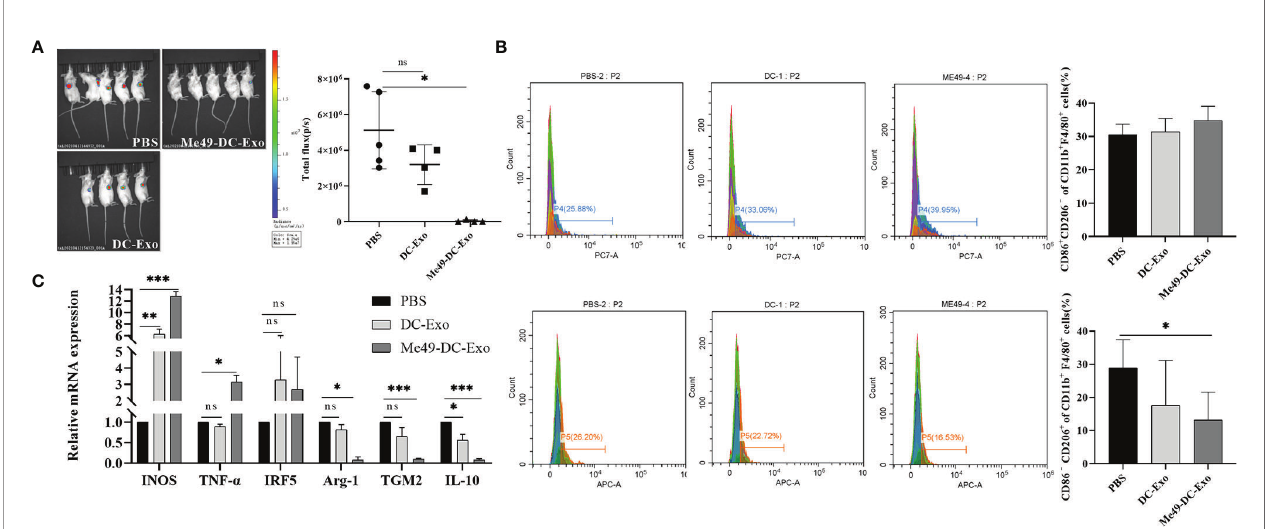
FIGURE 2 | Me49-DC-Exo inhibited tumor growth in mouse and regulated macrophage polarization. (A) On day 4 after treatment, the IVIS imager detected bioluminescence images in tumors of mouse and quanti fi ed the bioluminescence signal intensity of each tumor in mouse. (B) Flow cytometry was used to label CD86 + or CD206 +, and CD45 + CD11b + F4/80 + macrophages in blood of mice injected with DC-Exo and Me49-DC-Exo were stained to detect the percentage of CD86+ CD206 − M1 macrophages and CD86 − CD206 + M2 macrophages. (C) mRNA levels of M1 macrophage speci fi c genes (INOS, TNF-a, and IRF5) and M2 macrophage speci fi c genes (TGM2, Arg-1 and IL10) in blood of tumor-bearing mice injected intratumorally with PBS, DC-Exo and Me49-DC-Exo were detected by qRT-PCR. The data were expressed as mean ± standard deviation, and the independent sample t-test was used to compare the statistical differences between two groups. ns (p ≥ 0.05), *p < 0.05, **p < 0.01, ***p <